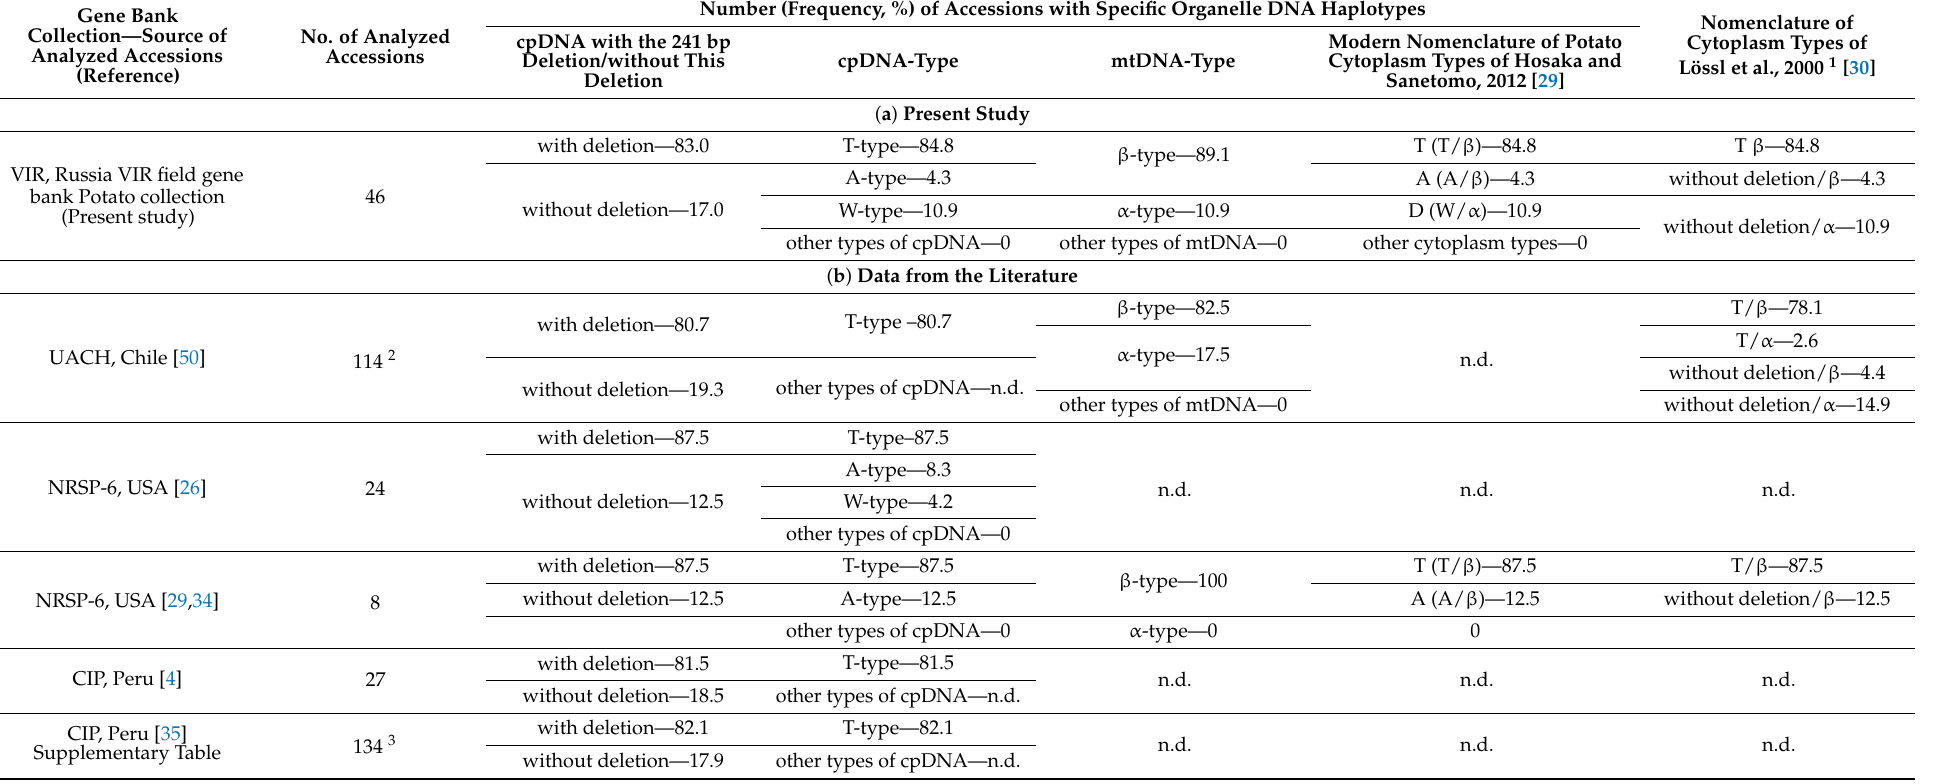
Table 2. Frequency of cpDNA, mtDNA haplotypes, and cytoplasm types that were determined in the living accessions of S. tuberosum Chilotanum Group (=